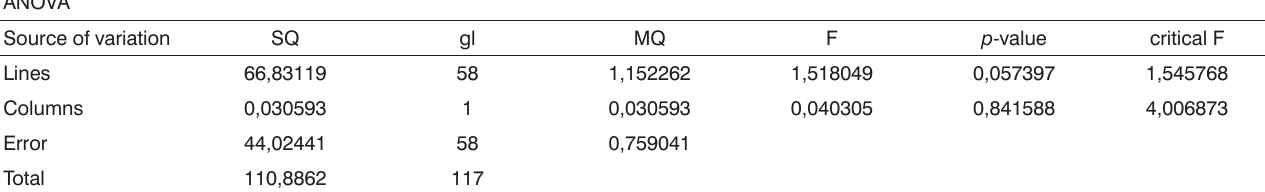
Table 5. Analysis of variance for the degree of reduction, comparing right and left